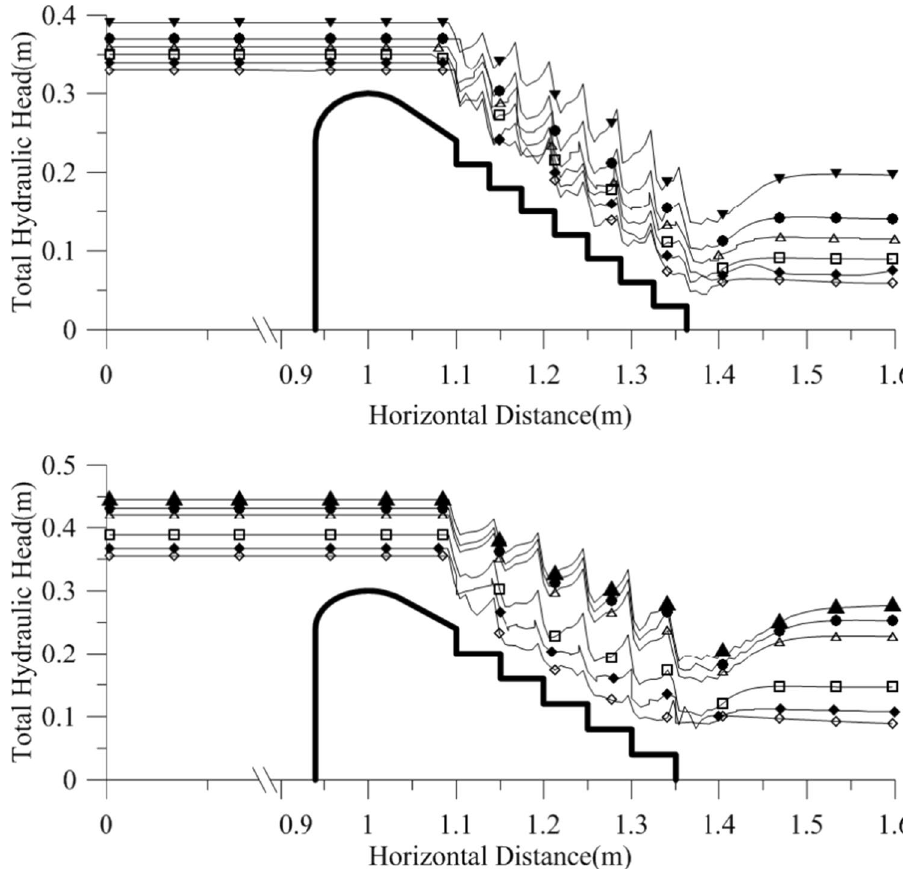
Fig. 8 The energy dissipation of flow on the